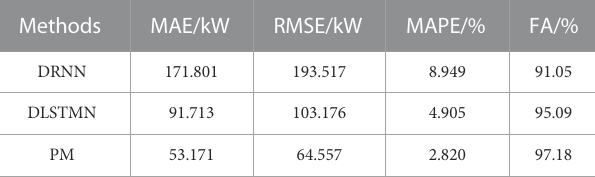
TABLE 2 Comparison of indicators of different